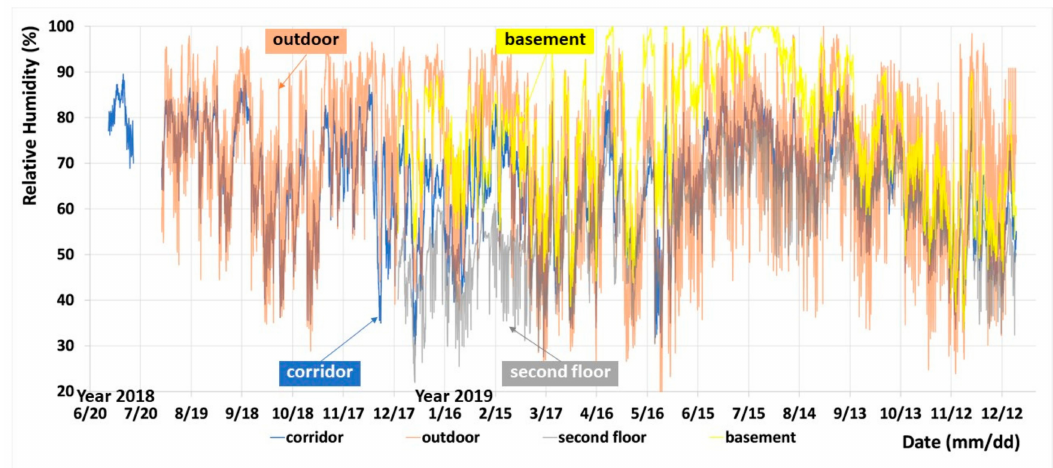
Figure 11. The measured relative humidity of the next rooms and the outdoors.